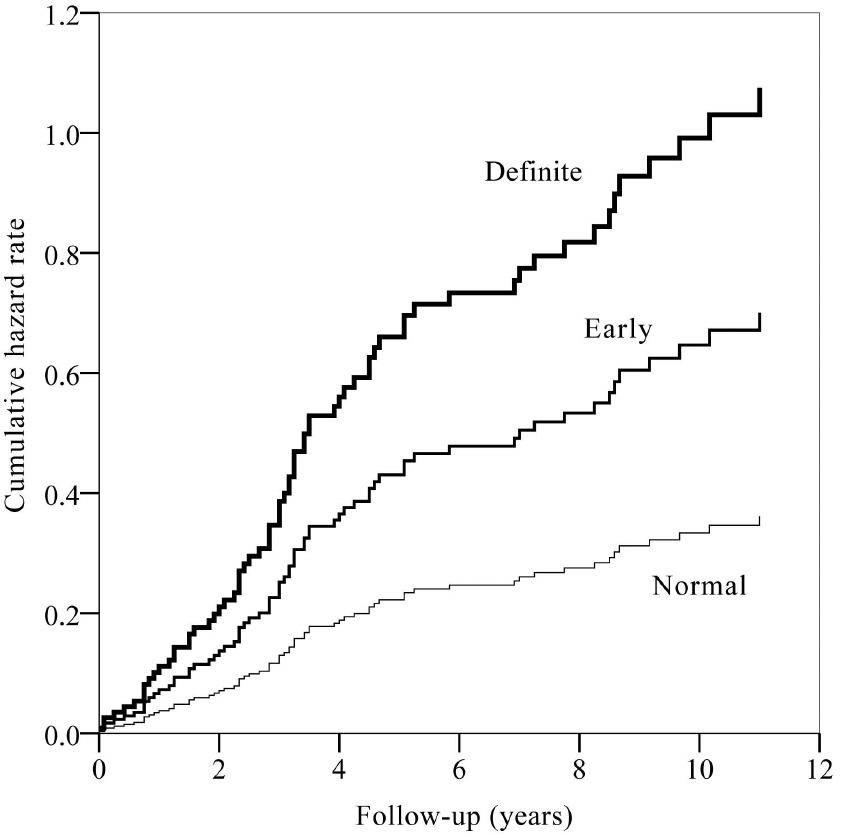
Fig 1. Cumulative hazard rate of recurrent cardiovascular diseases according to the stages of cardiovascular autonomic neuropathy in patients with type 2 diabetes. (log-rank P = 0.001).